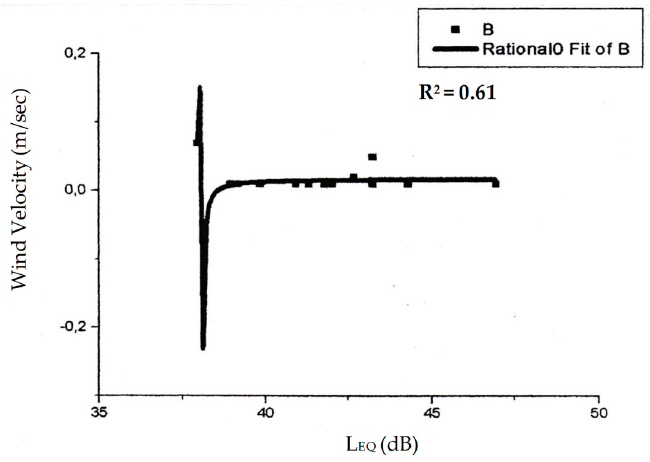
Figure 14. Correlation modeling between Relative Humidity and Noise Level at CW-T.